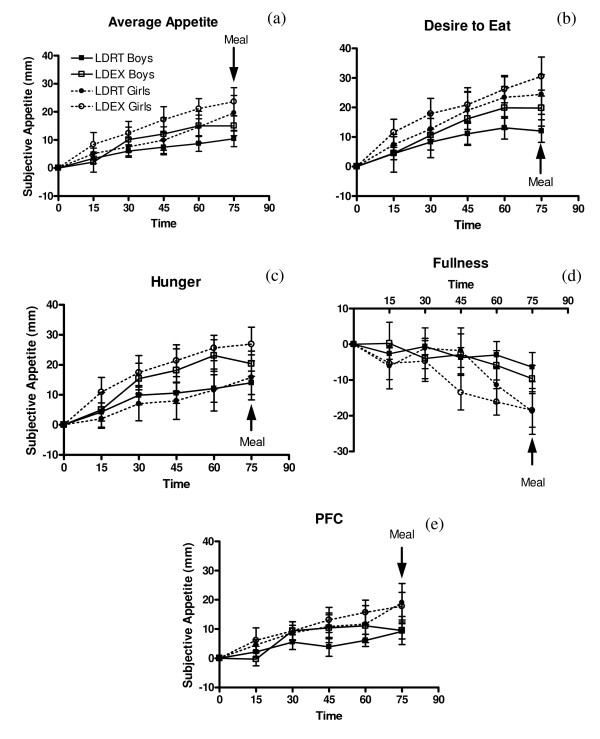
Effect of long-duration exercise at the VeT on subjective appetite scores. 1Average appetite (a) desire-to-eat (b) hunger (c) fullness (d) PFC (e) at 15, 30, 45, 60, and 75 min during long-duration sessions. 2LDRT = long-duration rest, LDEX = long-duration exercise, PFC = prospective food consumption. 3 Change from baseline average appetite (p < 0.0001), desire to eat (p < 0.0001), hunger (p < 0.0001), and PFC (p < 0.0001) increased with time, and fullness decreased (p < 0.001). LDEX stimulated a greater rate of increase in average appetite (p = 0.0045), desire to eat (p = 0.047), and hunger (p < 0.0001) compared with LDRT, however there was no effect on fullness (p = 0.19) or PFC (p = 0.18). Sex was not a factor on change from baseline average appetite (p = 0.22), desire to eat (p = 0.15), hunger (p = 0.80), fullness (p = 0.17), or PFC (p = 0.17). 4Test meal began at 75 min.